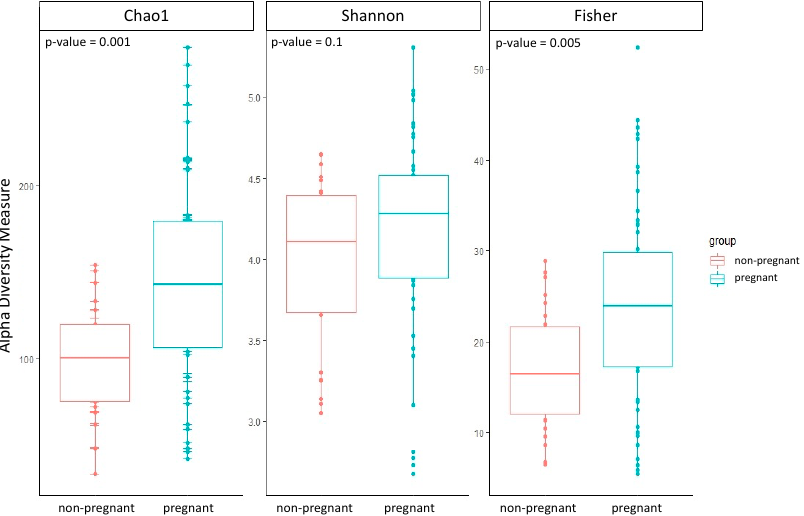
Figure 1. Boxplots of the three alpha diversity indices were calculated for both groups of pregnant and non-pregnant women. The p -value was estimated using the Wilcoxon test. Overall, the microbiome composition was similar between the pregnant and non- pregnant groups. We estimated the core microbiome at a 5% abundance threshold for each group. The relative abundance of seven genera was different between the two groups (Figure 2). Pseudomonas, Gulbenkiania , Enterococcus , and Burkholderia–Caballeronia– Paraburkholderia were identified only in the non-pregnant group core microbiome. These taxa were excluded from the core microbiome of the pregnant women group, as they had a mean relative abundance of ≤ 5%. On the contrary, pregnant women had a higher abundance of Acinetobacter and Enhydrobacter ( p -value = 0.019, and 0.043 respectively), and in addition, the Psychrobacter genus was identified only in the core microbiome of the pregnant group. We performed pathway analysis and observed differences in the abundance of 25 pathways (Figure 3). Specifically, 18 pathways were reduced in pregnant women, while 7 were increased (i.e., PWY-6728, PWY-7031, PWY-7198, THISYN-PWY,